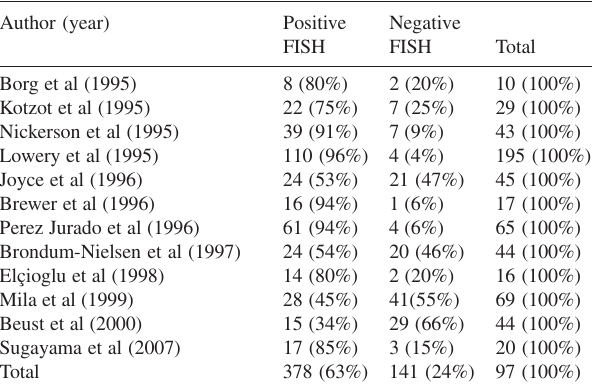
Table 3 - Frequency of patients with Williams syndrome that were FISH-positive and FISH-negative from the literature, and for our